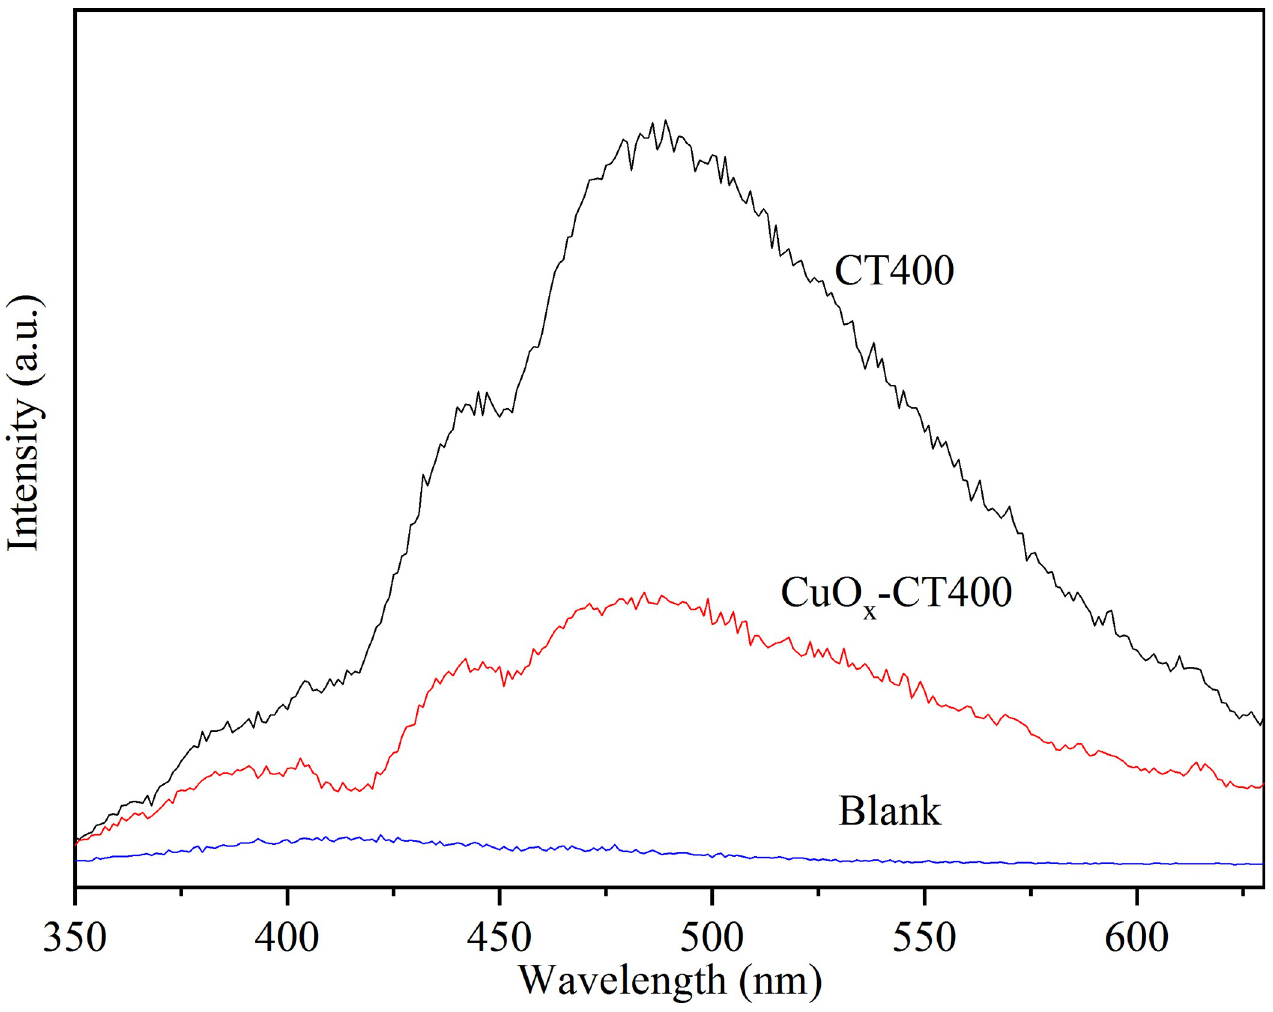
Fig 8. PL spectra of CT400 and CuO x